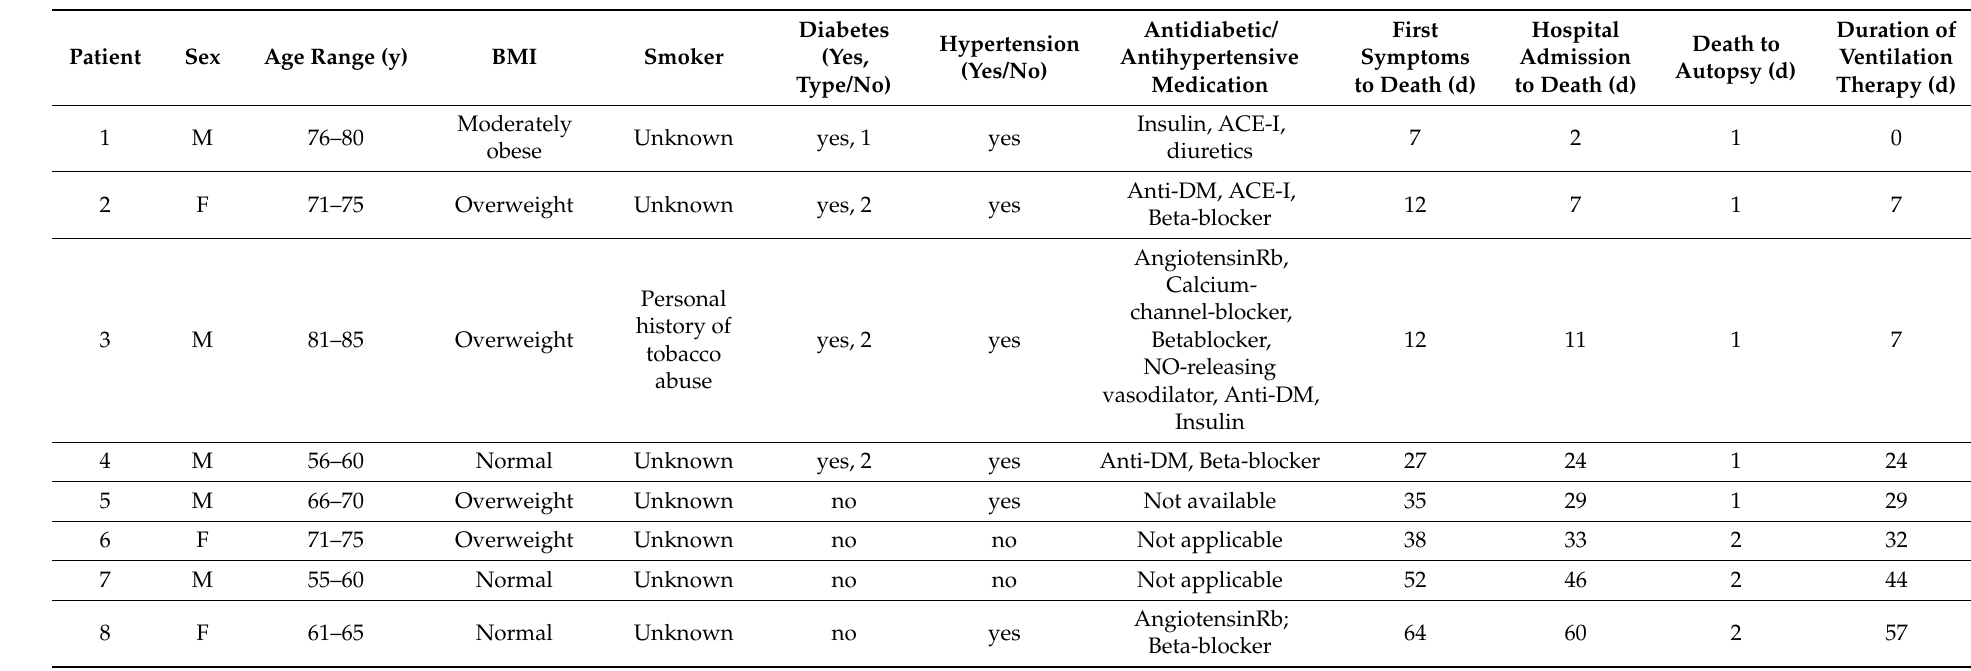
Table 1. Patient characteristics of our COVID-19 study